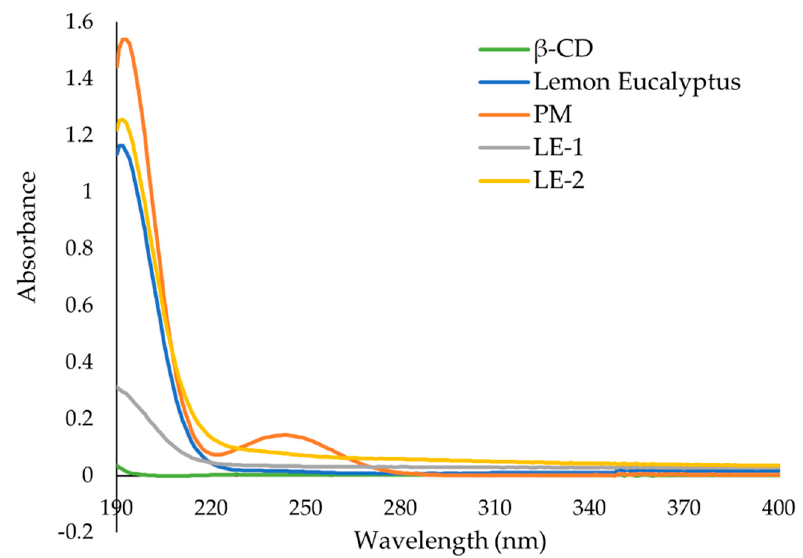
Figure 9. UV-Vis spectra of β -cyclodextrin ( β -CD), lemon eucalyptus (LE) essential oil, physical mixture of both (PM) and the inclusion complexes LE-1 and LE-2. Solutions were prepared in water and have the same β -CD or essential oil concentration where applicable.